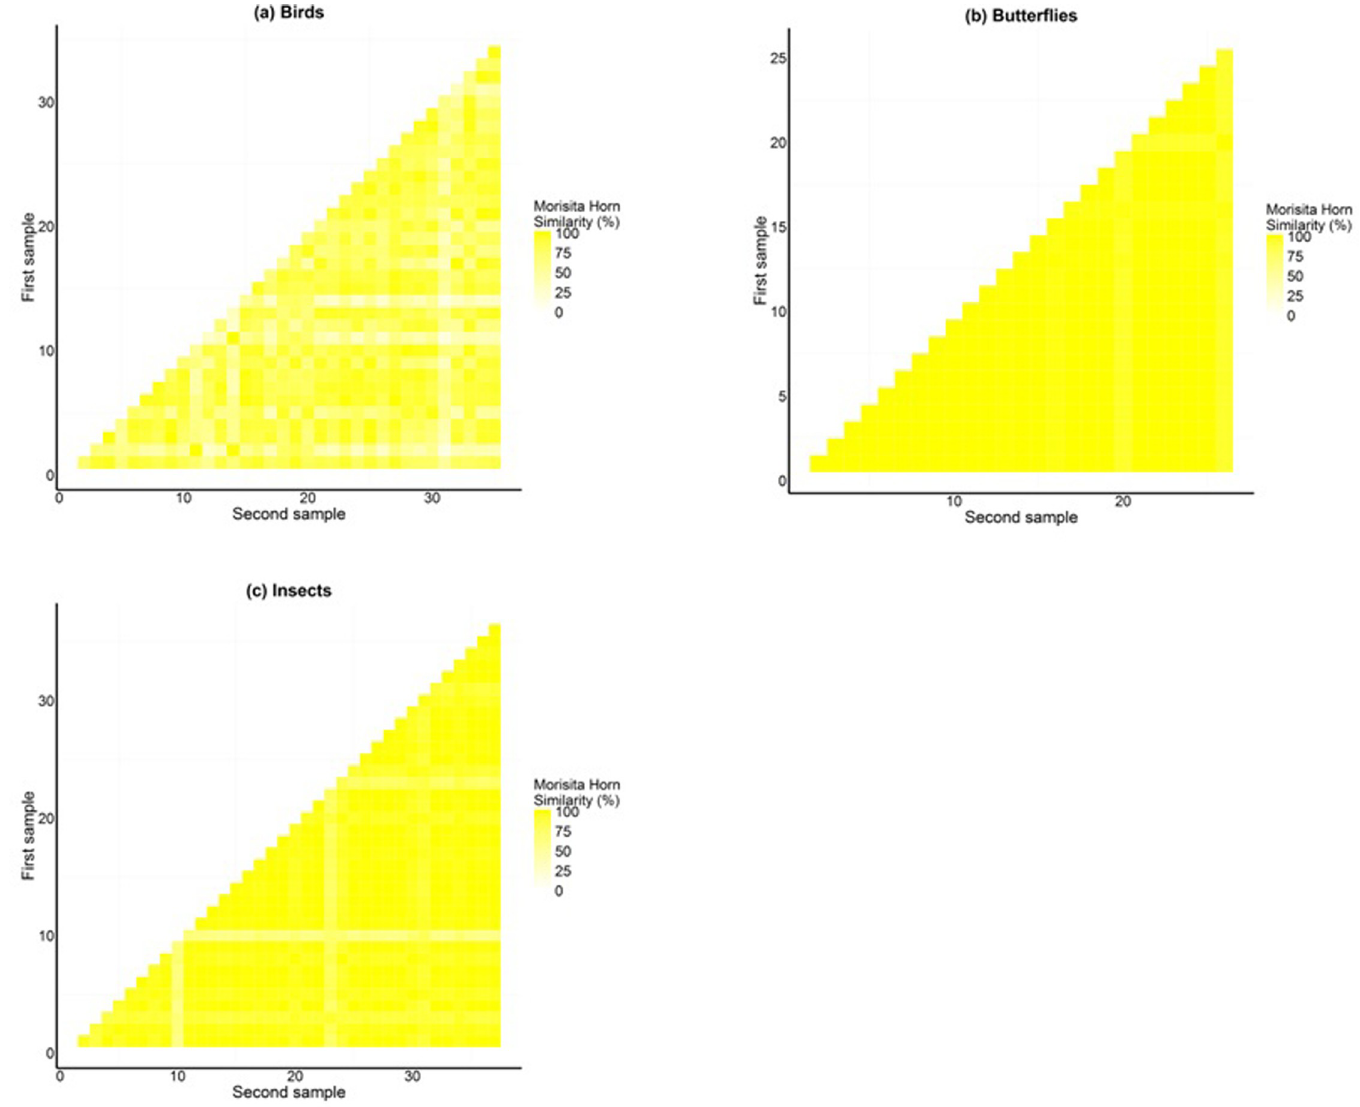
Fig 8. A visual representation of Morisita-Horn index indicating species assemblages across 1. Park scale for a) Birds; (b) Butterflies and (c) Insects.